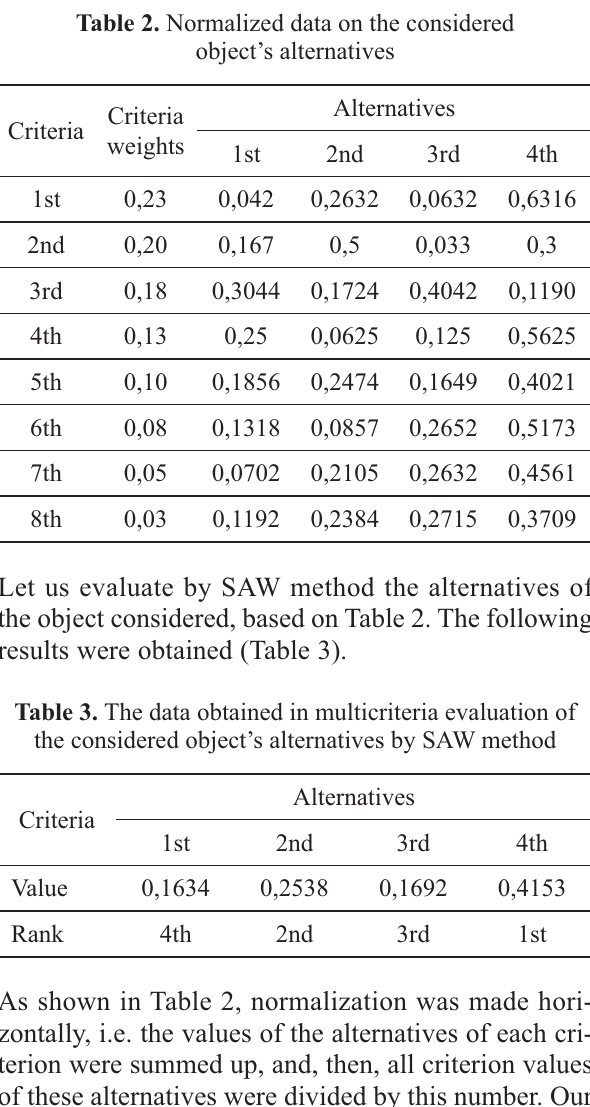
Table 2. Normalized data on the considered